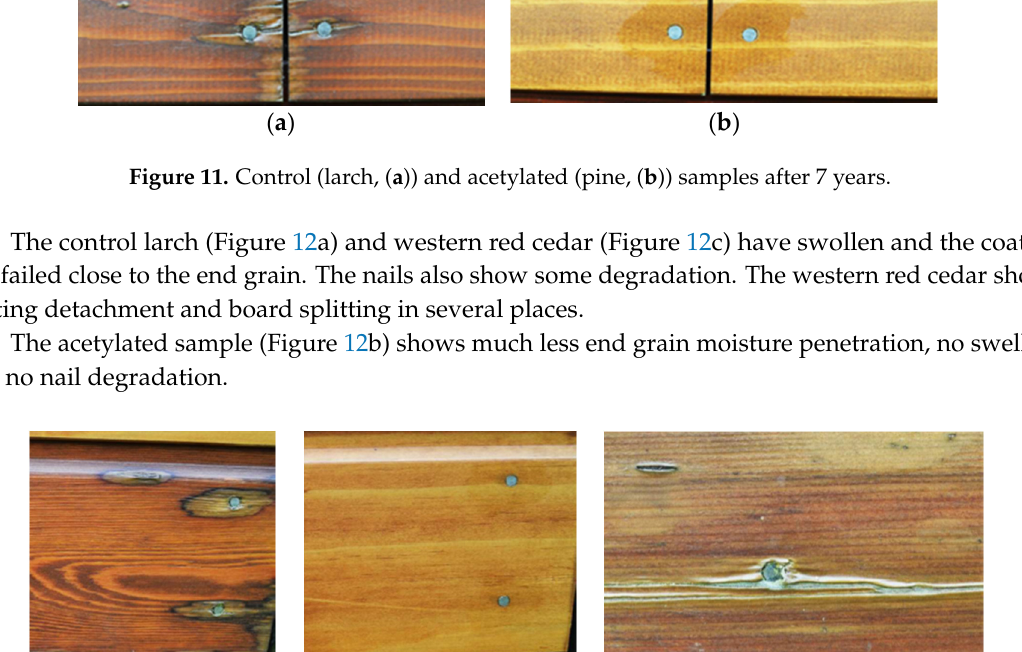
( b ) Figure 13. Opaque white alkyd coated control ( a ) and acetylated ( b ) after 9.5 years [11,12].